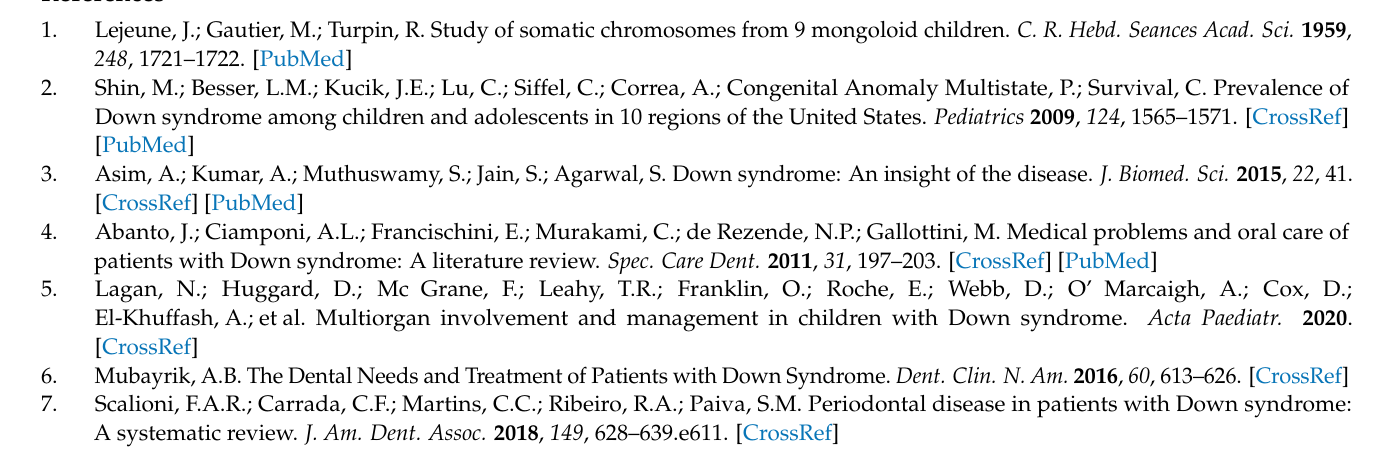
Supplementary Table S2. Demographic characteristics for the complete study population. Supplemen- tary Table S3. Periodontal clinical outcomes, expressed as means and standard deviations (SD), for the complete study population and for each study group. Supplementary Table S4. Microbiological findings (counts and frequencies of detection), as evaluated by means of quantitative polymerase chain reaction, expressed as means and standard deviations (SD), for the complete study population and for each study group. Supplementary Table S5. Microbiological findings, as evaluated by means of culture, with counts expressed as means and standard deviations (SD) and frequencies of detection expressed as percentage, for the complete study population and for each study group. Supplementary Table S6. Microbiological findings (proportions), as evaluated by means of culture, expressed as means and standard deviations (SD), for the complete study population and for each study